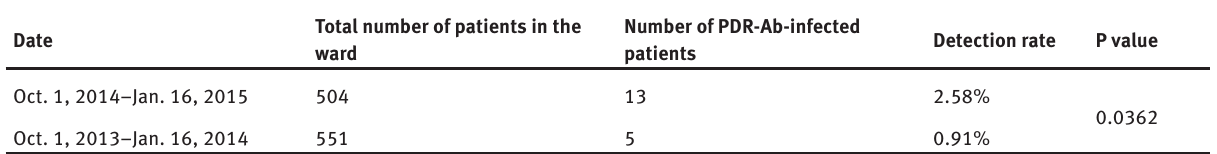
Table 1: Comparison of the PDR-Ab detection rates during different time periods.